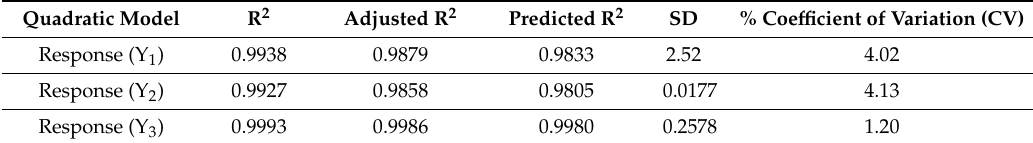
Table 3. Summary of regression analysis for responses Y 1 (particle size in nm), Y 2 (PDI), and Y 3 (Zeta